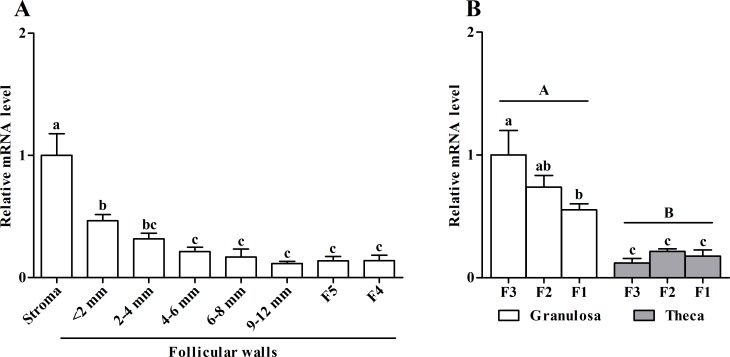
Expression pattern of PRLR mRNA in chicken developing follicles.(A) Abundance of PRLR mRNA in the stroma and walls of prehierarchical (< 2, 2–4, 4–6 and 6–8 mm) and preovulatory (9–12 mm, F5 and F4) follicles. (B) Relative PRLR mRNA levels in theca and granulosa cell layers isolated from the three largest preovulatory follicles (namely F3-F1; F3 < F2 < F1). Relative expression level was normalized to 18S rRNA. Data are expressed as fold differences ± SEM compared to either the stroma or F3 granulosa cells (n = 4 hens). Different lowercase letters indicate a significant effect of follicular developmental stage, whilst different uppercase letters indicate a significant effect of cell type (granulosa versus theca cell layer). P < 0.05 was accepted as statistically significant.